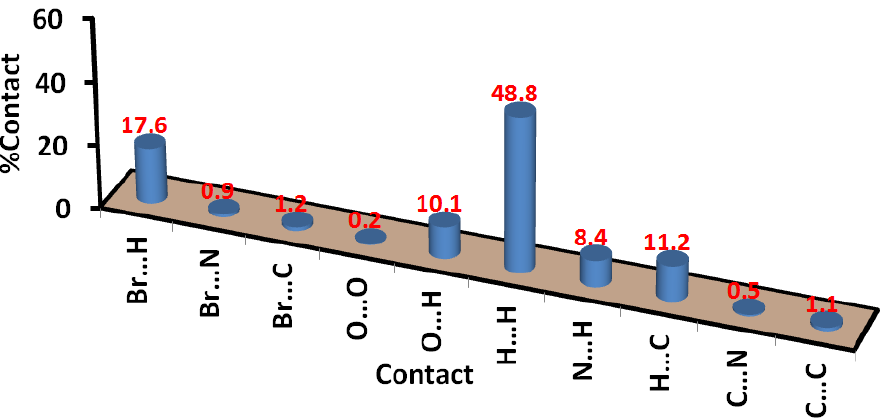
Figure 4. Percentages of all intermolecular contacts in the [Co(L)(H 2 O) 2 Br]Br complex. On the other hand, the Br…H contacts appeared as red regions, indicating a shorter distance than the vdWs sum of the Br and H atoms (Figure 5). Additionally, the Br…H contacts appeared as sharp spikes in the fingerprint plot revealed short distance atom-atom interactions. The Br2…H1A (2.307 Å), Br1…H1B (2.368 Å), Br2…H13 (2.655Å), Br2…H9A (2.708 Å), and Br2…H12 (2.781 Å) contacts are the most important.